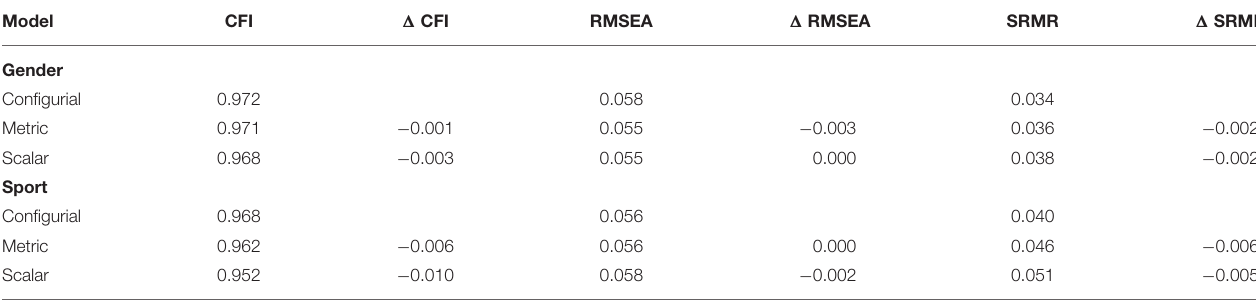
TABLE 3 | Goodness-of-fit statistics and model comparisons for the multigroup confirmatory factor analyses. Model